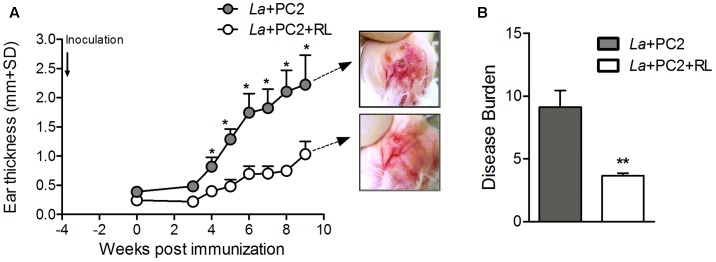
Lesion development in mice inoculated with in vitro PC2-sensitized/photo-inactivated L. amazonensis. BALB/c mice were inoculated with PC2-sensitized L. amazonensis (La) with (open circle/white bar) and without (gray circle/gray bar) prior red light exposure (RL). (A) Ear thickness was measured weekly for 9 weeks. Photomicrographs show differential severity in the appearance of the ear lesions at the end point. (B) Disease burden calculated by mapping the diseased areas under the curves (AUC) in (A). Data are presented as mean ± SD from control and experimental groups, each consisting of six mice (∗p < 0.05, ∗∗p < 0.001, Mann–Whitney test).